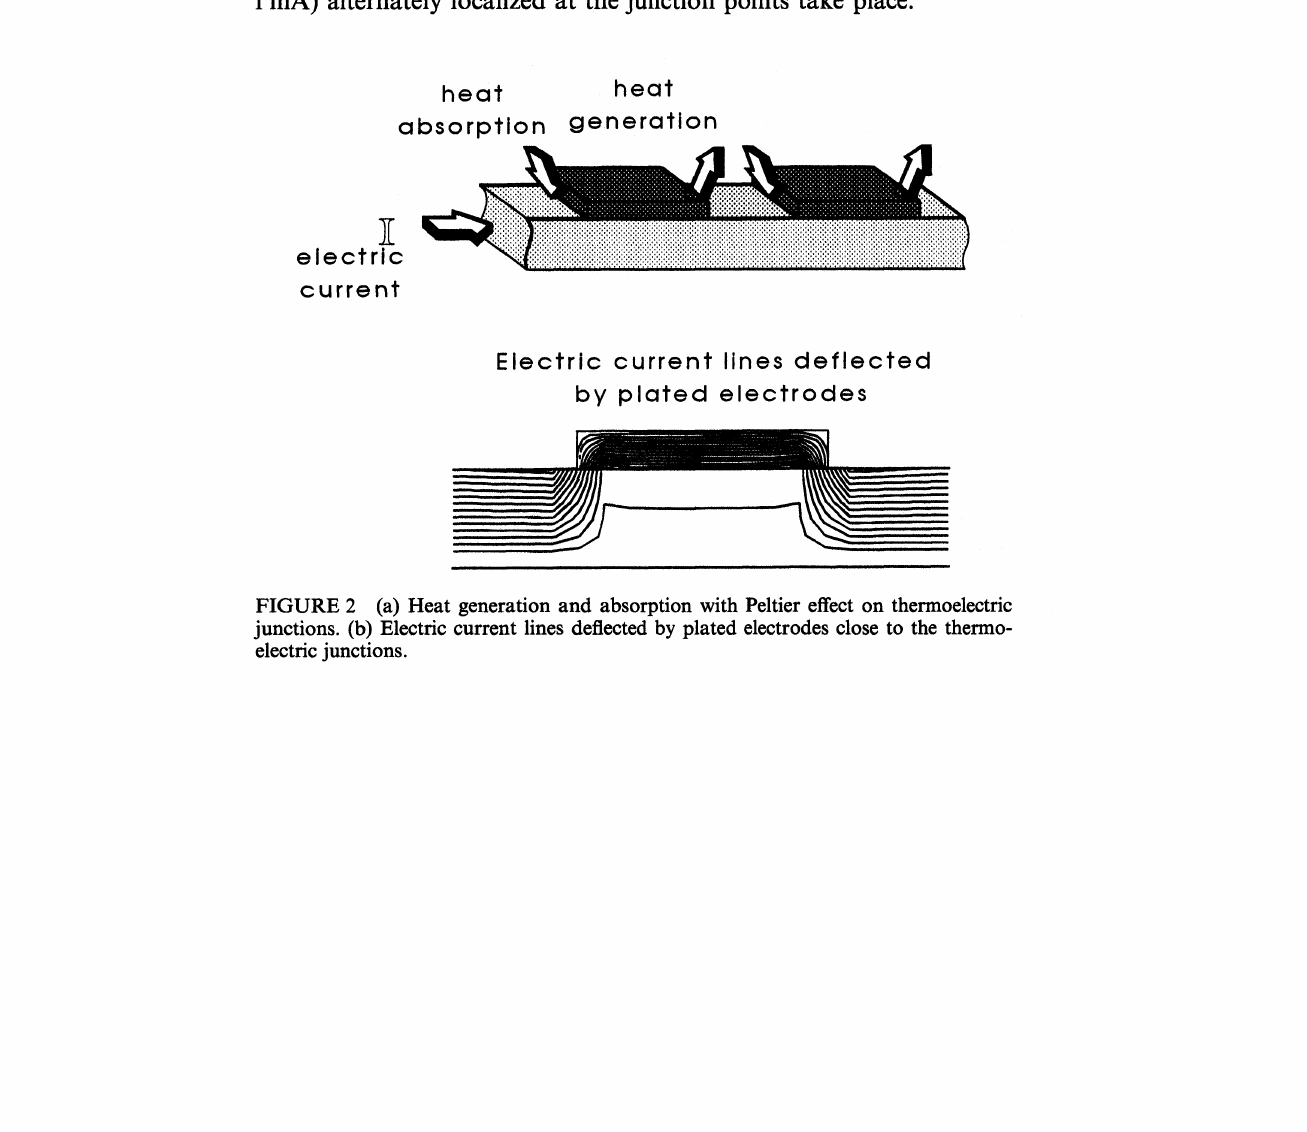
FIGURE 2 (a) Heat generation and absorption with Peltier effect on thermoelectric junctions. (b) Electric current lines deflected by plated electrodes close to the thermo- electric